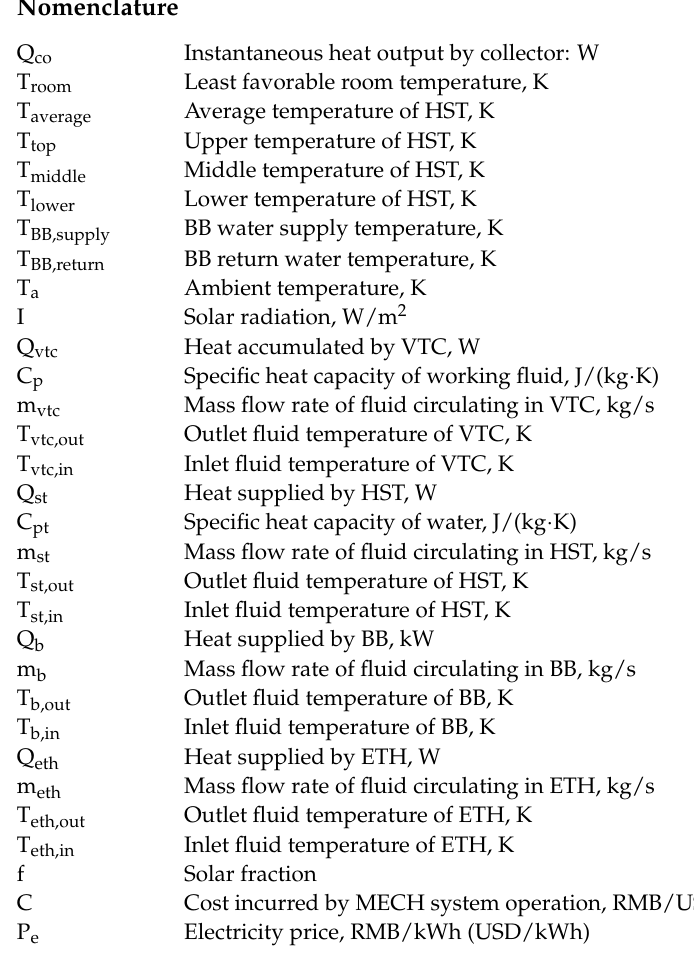
Table S2: Main parameters of test instruments; Table S3: Statistics of key operational data in Mode 1. Table S4: Statistics of key operational data in Mode 2; Table S5: Statistics of key operational data in Mode 3; Table S6: Statistics of key operational data in Mode 4; Figure S1: Thermal load of the building in winter; Figure S2: Dry bulb temperature and solar radiation (I solar ); Figure S3: Experimental test data: (a) BB heating and (b) ETH